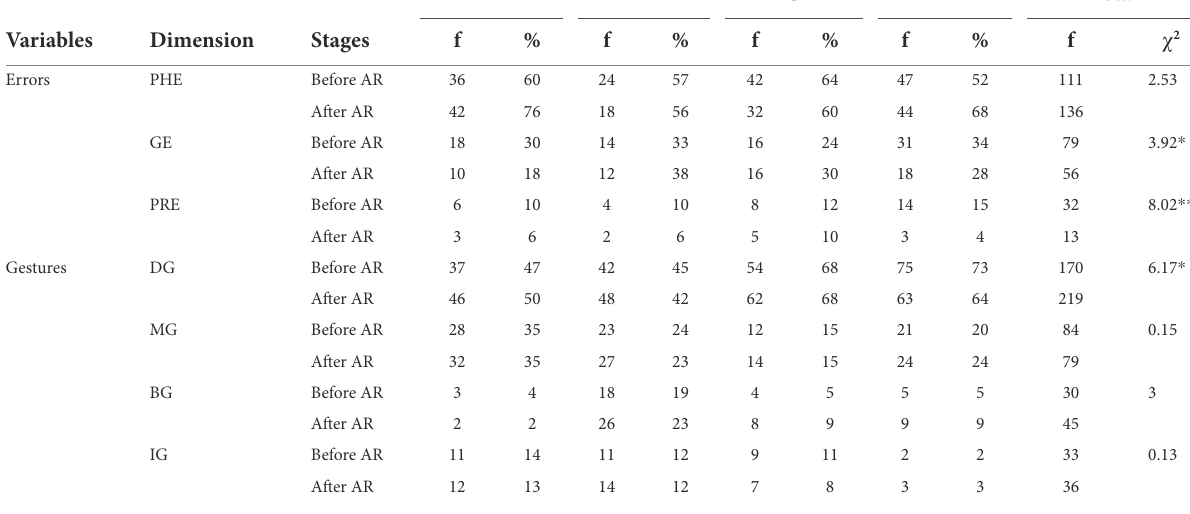
TABLE 4 Description of errors and gestures before and after